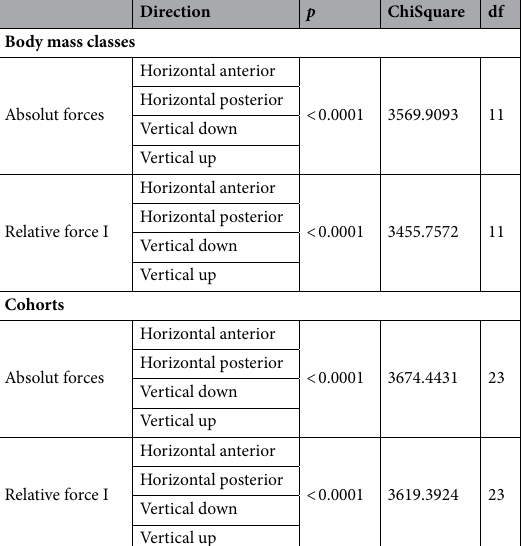
Direction p ChiSquare